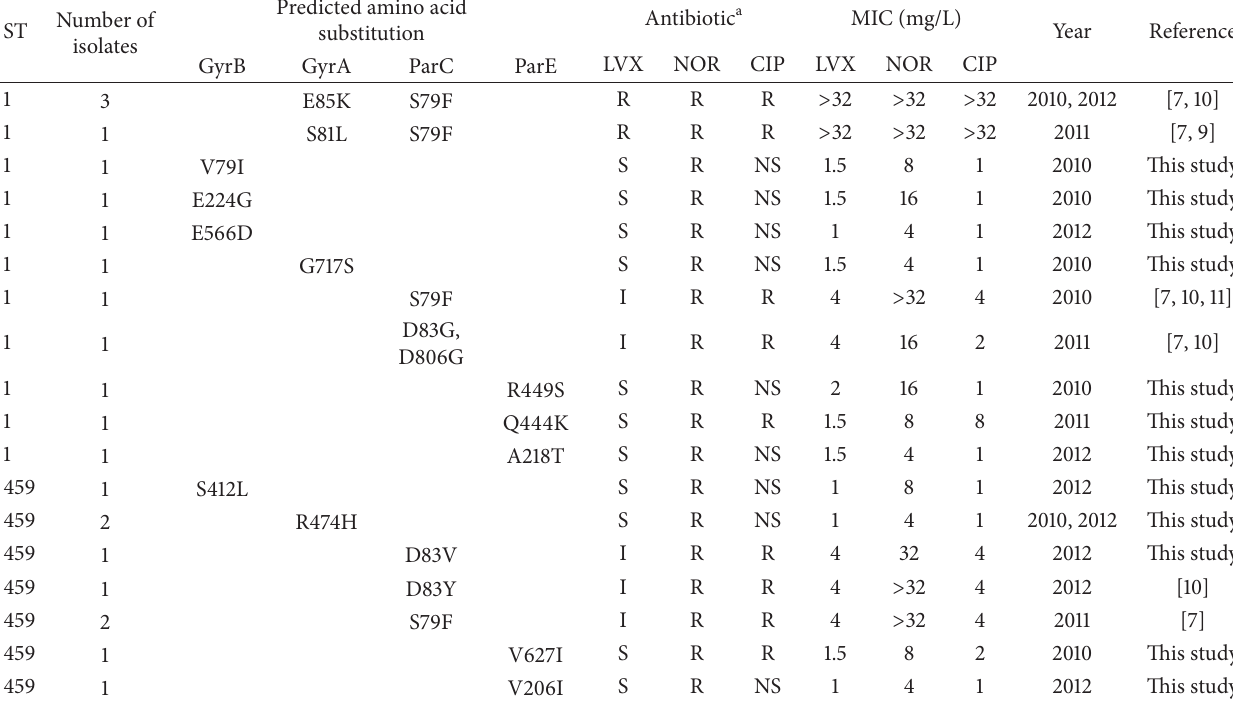
Table 2: Characteristics of mutations observed in GyrA, GyrB, ParC, and ParE among ST459 and ST1 group B Streptococcus isolates used in this